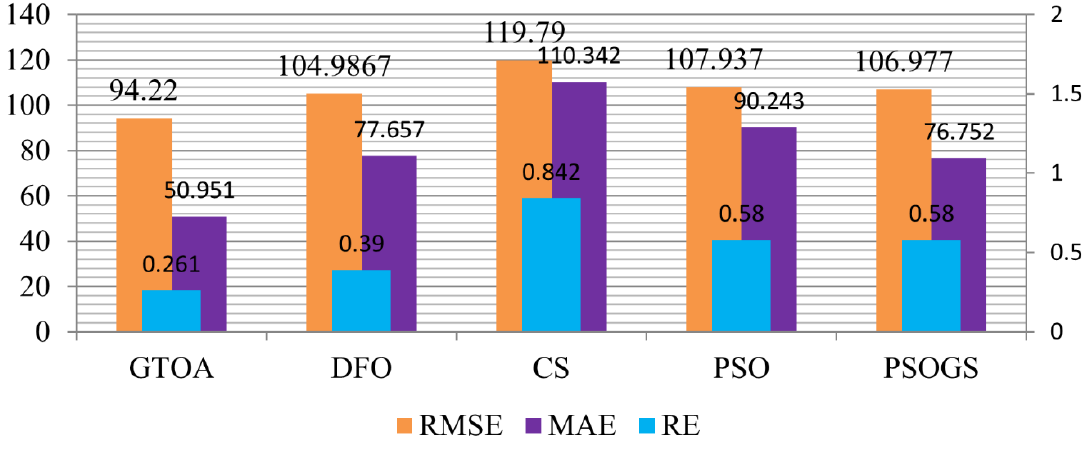
Figure 33. Comparative analysis of root means square error (RMSE), mean absolute error (MAE), and relative error (RE).